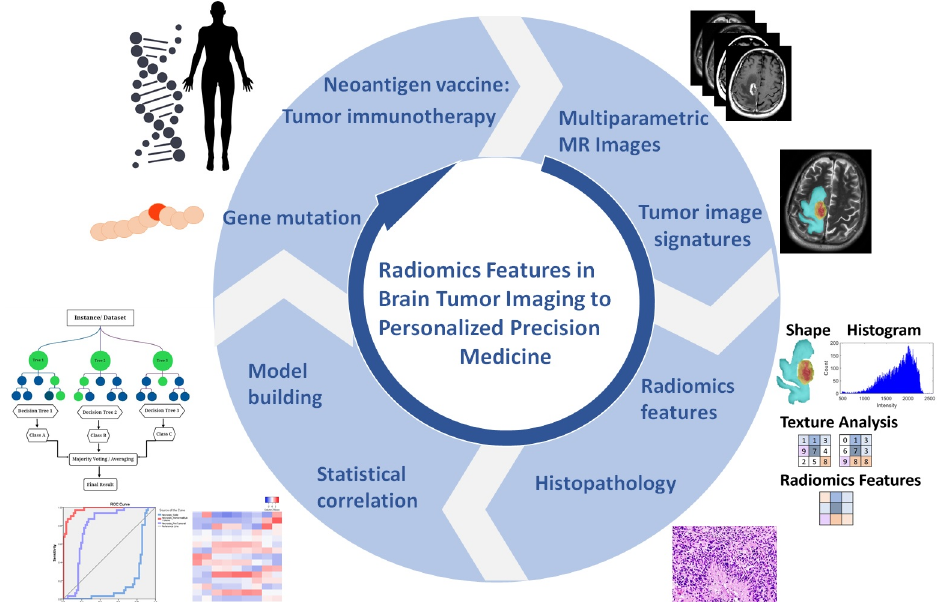
Figure 1. From bench to bedside, translational imaging research can advance to personalized medicine. Clinical implementation of radiomics studies workflow in neuro-oncology includes the following steps: (1) multimodal imaging and biological data labelling; (2) radiomics feature extraction and clinical information integrated model; (3) statistical correlation and machine learning model training; (4) bioinformatics for guiding personalized disease diagnosis, treatment evaluation, and prognostic prediction in precision medicine.